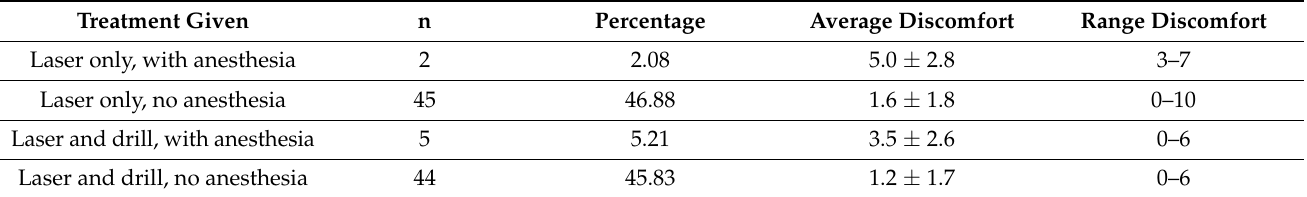
Table 1. Discomfort values by procedure type.